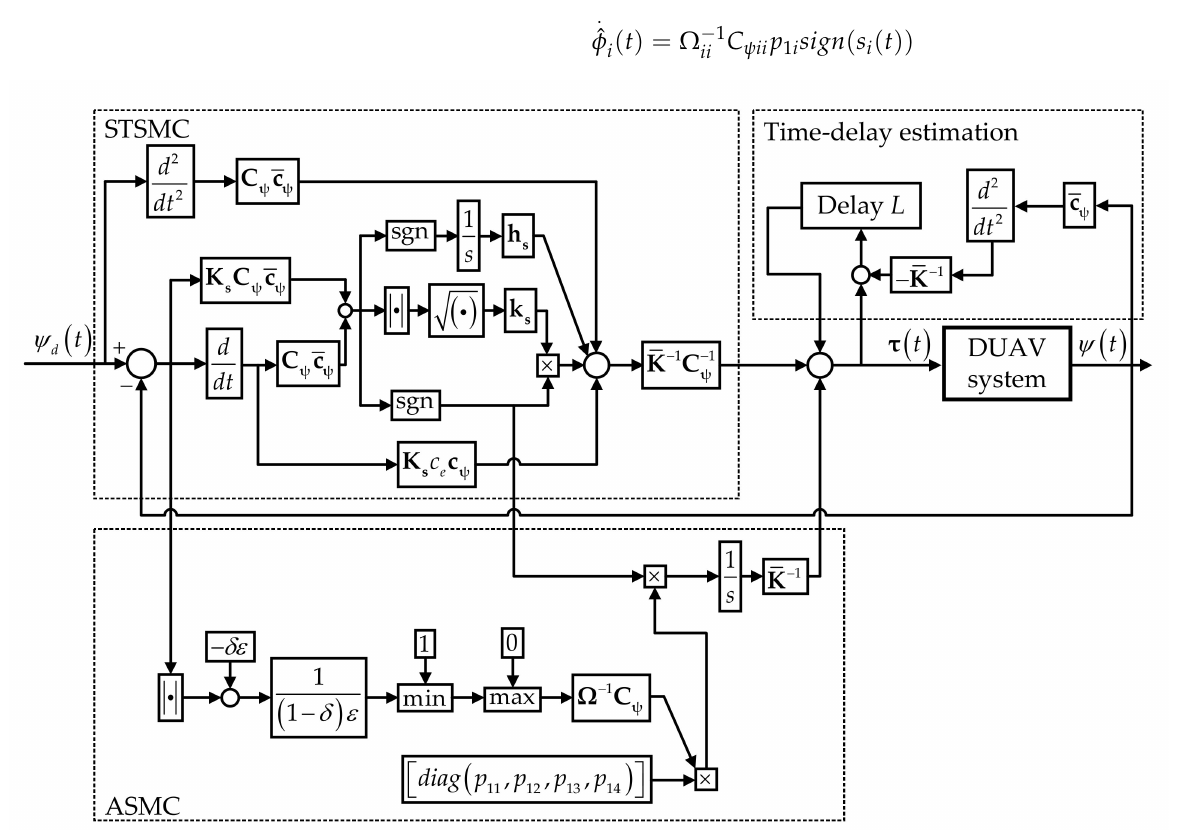
Figure 4. Block diagram of the proposed controller (ASTSMC –